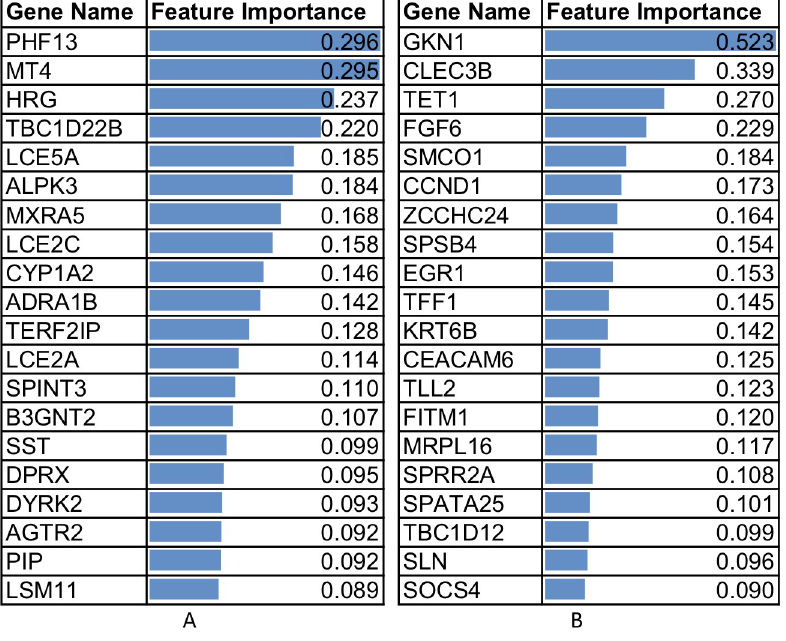
Fig 2. Top 20 genes and average SHAP impact (absolute values) on the magnitude of model classification output. (A) Values for the lung tissue. (B) Values for muscle-skeletal tissue. It can be seen that GKN1 gene expression values have the highest impact on the MV